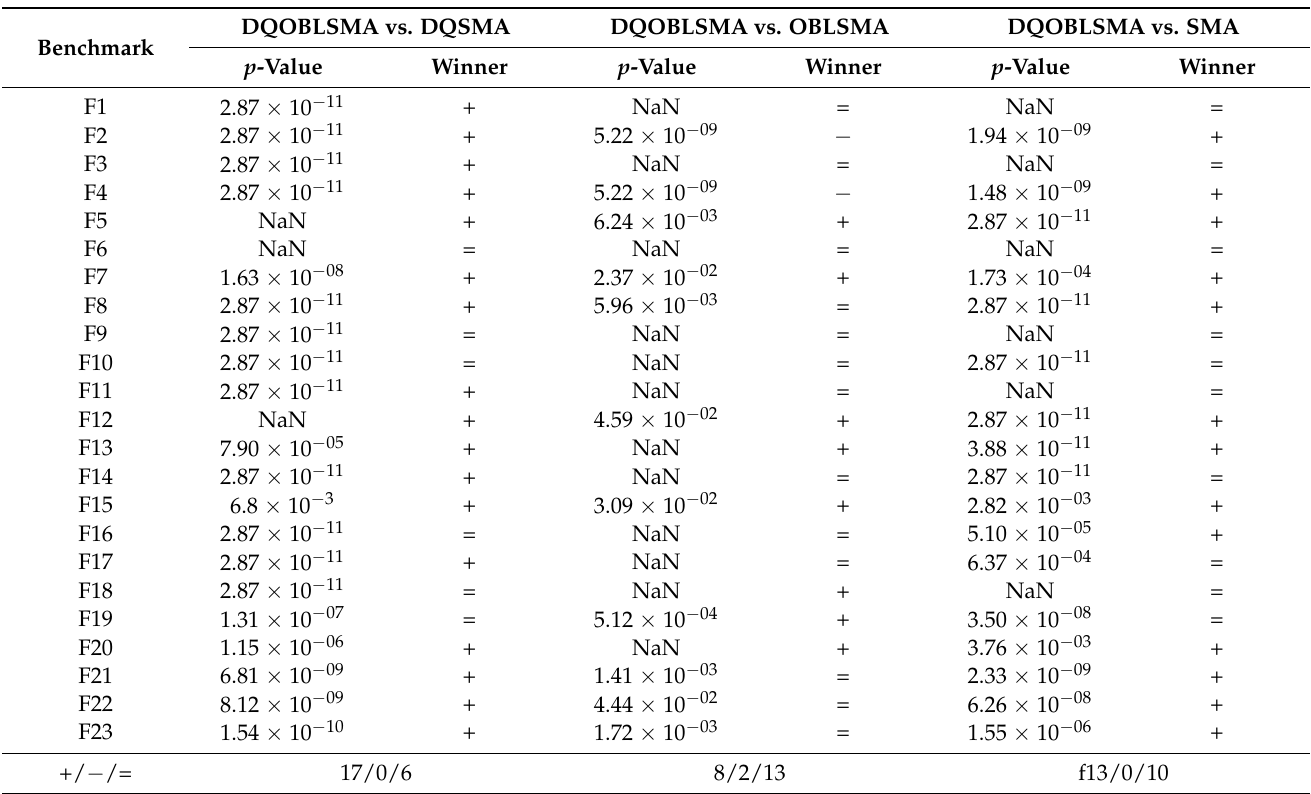
Table 5. Test statistical results of Wilcoxon’s rank-sum test.